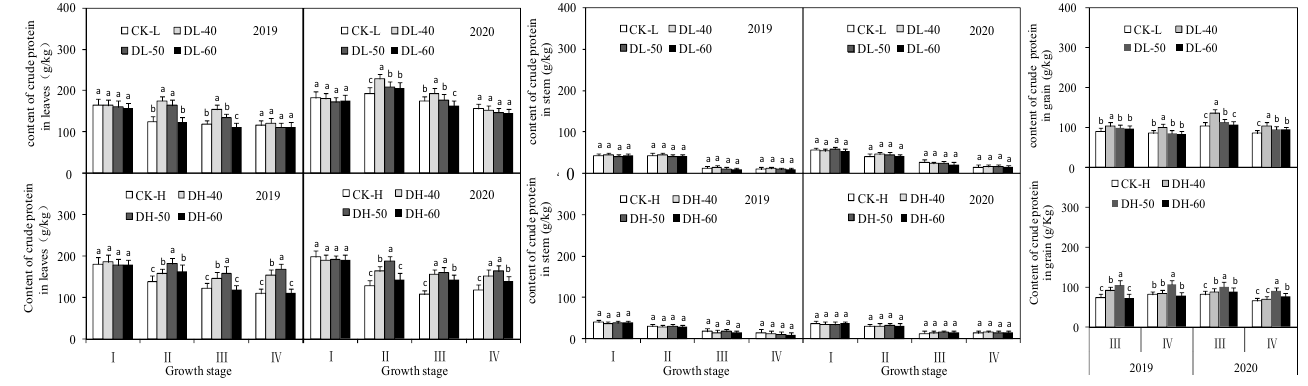
Figure 7. Effects of density and fertilization on the crude protein content in organs of forage maize. Note: Different letters on bars indicate significant differences among treatments at the 0.05 probability level.